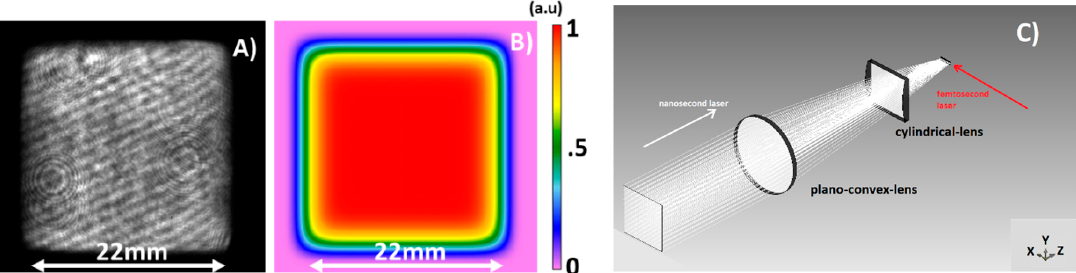
Figure 1. ( A ) Measured transverse distribution of the Bivoj nanosecond laser; ( B ) simulated transverse distribution of the Bivoj laser; ( C ) 3D-axis and optical scheme used to produce a knife-like focus: a 200- mm-focal-length plano-convex lens coupled with a 100-mm-focal-length cylindrical lens.